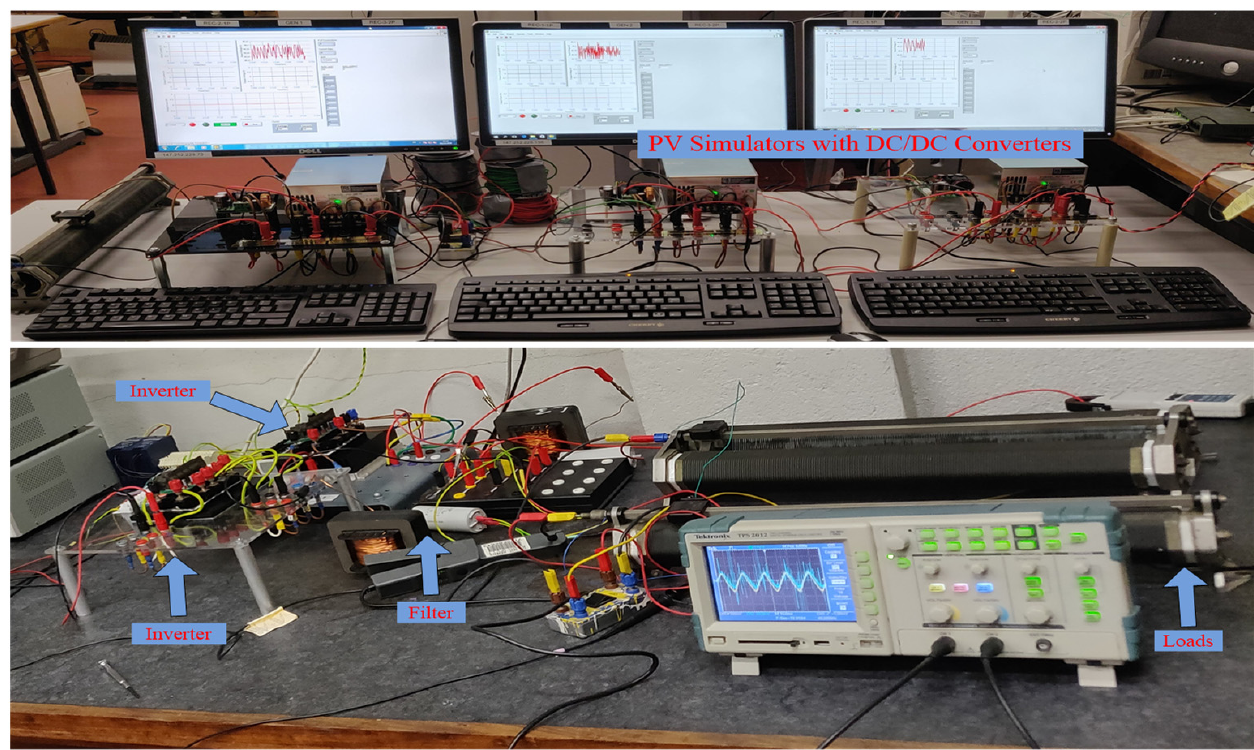
Figure 11. Experimental prototype of the proposed system.